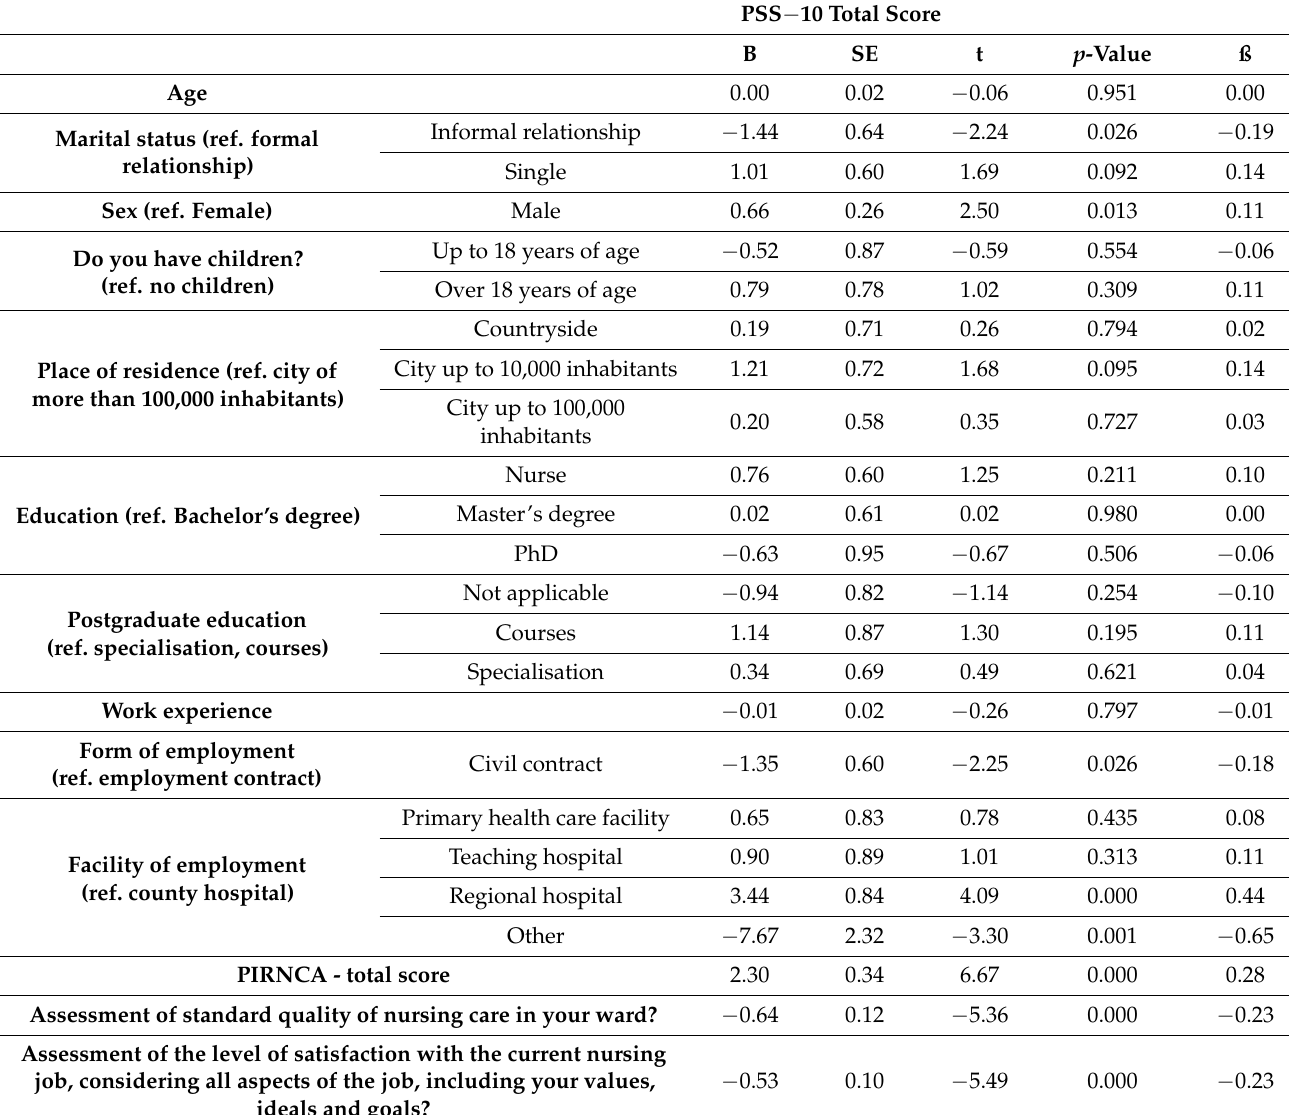
Table 5. Results of linear regression analysis of the effect of the selected variables on the perceived level of stress (PSS −